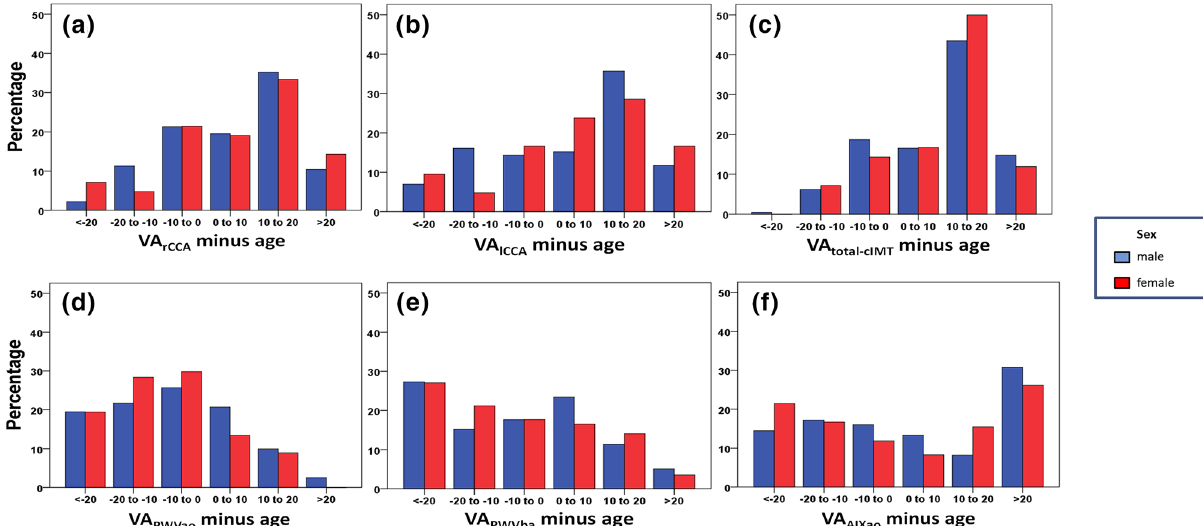
Figure 1. Percentage distribution of VA rCCA minus age ( a )), VA lCCA minus age ( b )), VA total-cIMT minus age ( c )), VA PWVao minus age ( d )), VA PWVba minus age ( e )) and VA AIXao minus age ( f )). Visualisation of accelerated vascular aging (i.e., vascular age exceeding chronological age) by the distribution of the difference of vascular and chronological age. A negative value represents vascular pre-aging. Since analyses were performed with “81 years” being the maximum VA of the cIMT examination, only patients aged < 61 years could possibly enter the group of individuals exhibiting pre-aging of > 20 years. In general, vascular age derived from PWA (first row) was similar or even smaller than patients´ age while VA derived from cIMT (second row) delivered opposite results. VA vascular age, PWVao aortic pulse wave velocity, PWVba branchial-ankle pulse wave velocity, AIao aortic augmentation index, rCCA right common carotid artery, lCCA left common carotid artery, total-cIMT total carotid intima-media